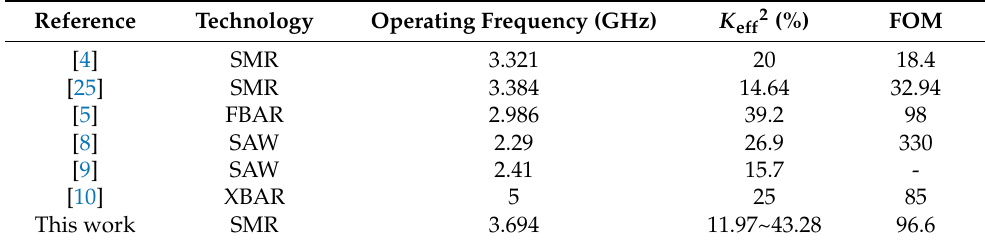
Table 2. LN-based acoustic resonators with different